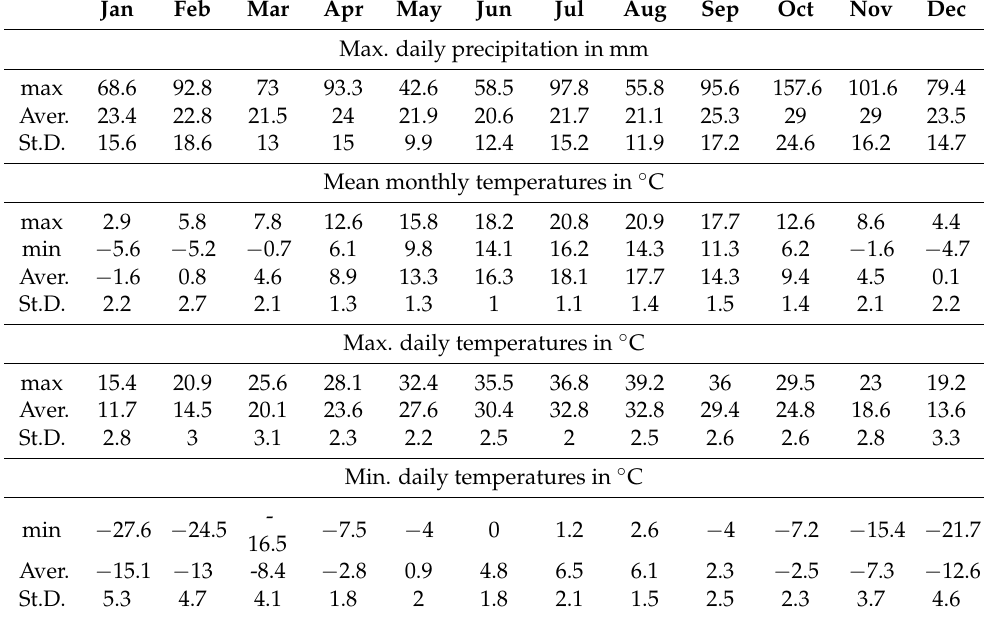
Table 1. Precipitation and temperature in the period 1948–2020 in the studied area. Jan